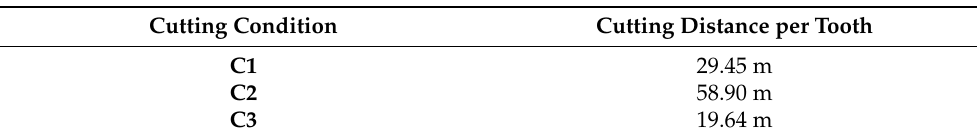
Table 7. The cutting distance per tooth.